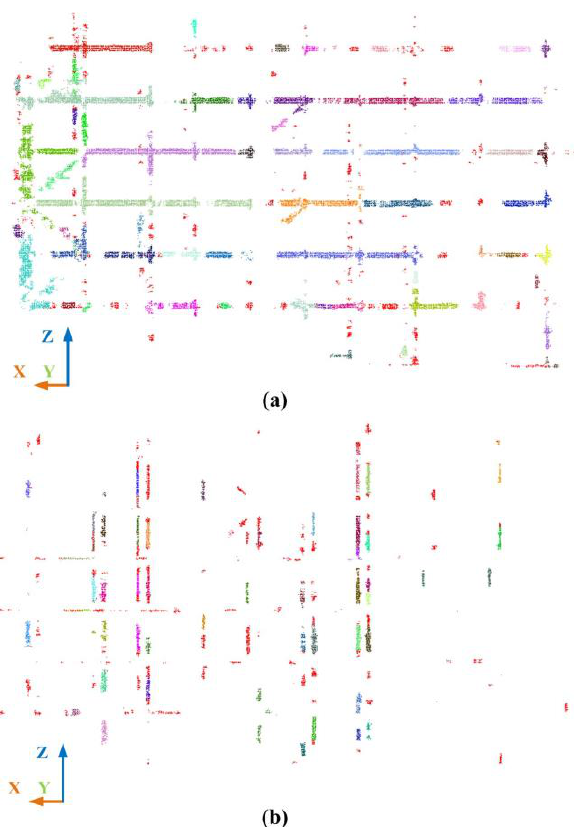
Figure 11. Classifiacation and segmentation results, a) points of toeboards, b) points of tubes.